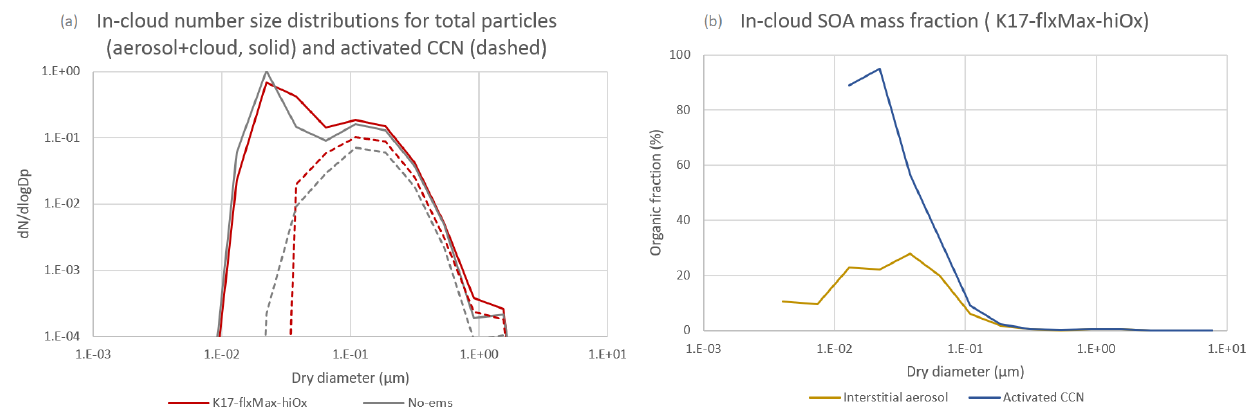
Figure 10. (a) in-cloud total particle (aerosol + cloud, solid lines) and cloud droplet (dashed lines) dry-size number distribution; (b) in-cloud SOA mass fraction in interstitial aerosol (beige) and activated CCN (blue) for the K17-maxFlx-hiOx case, 6h after simulation start, mean over cloud layer.